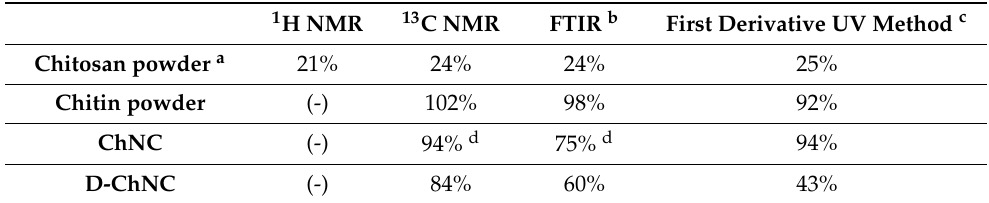
Table 1. DA (%) of chitin-based samples found for 1H NMR, 13C NMR and the first derivative UV method.